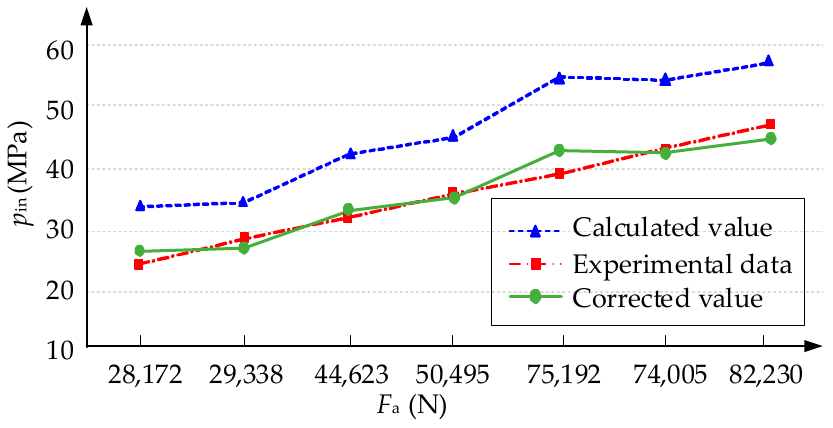
Figure 12. Errors in inner cavity pressure sealing test data.